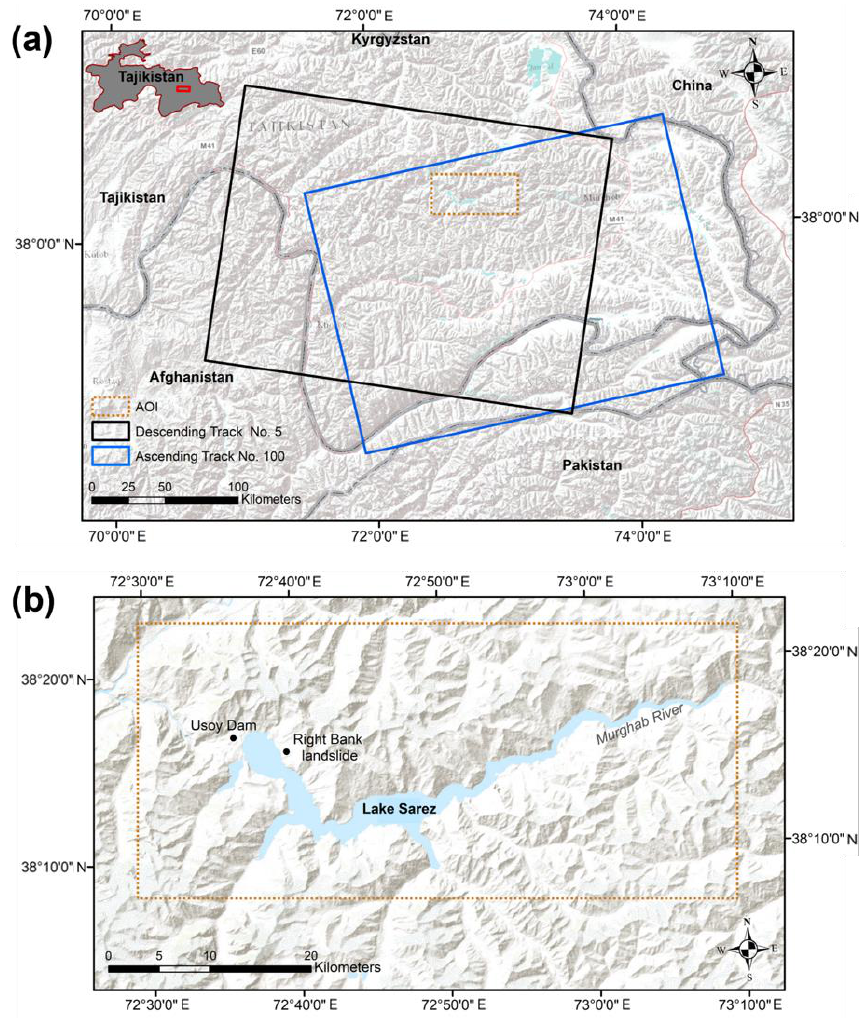
Figure 1. The location of Lake Sarez. ( a ) The coverage of the ascending and descending Sentinel-1 frames, and ( b ) study area of interest